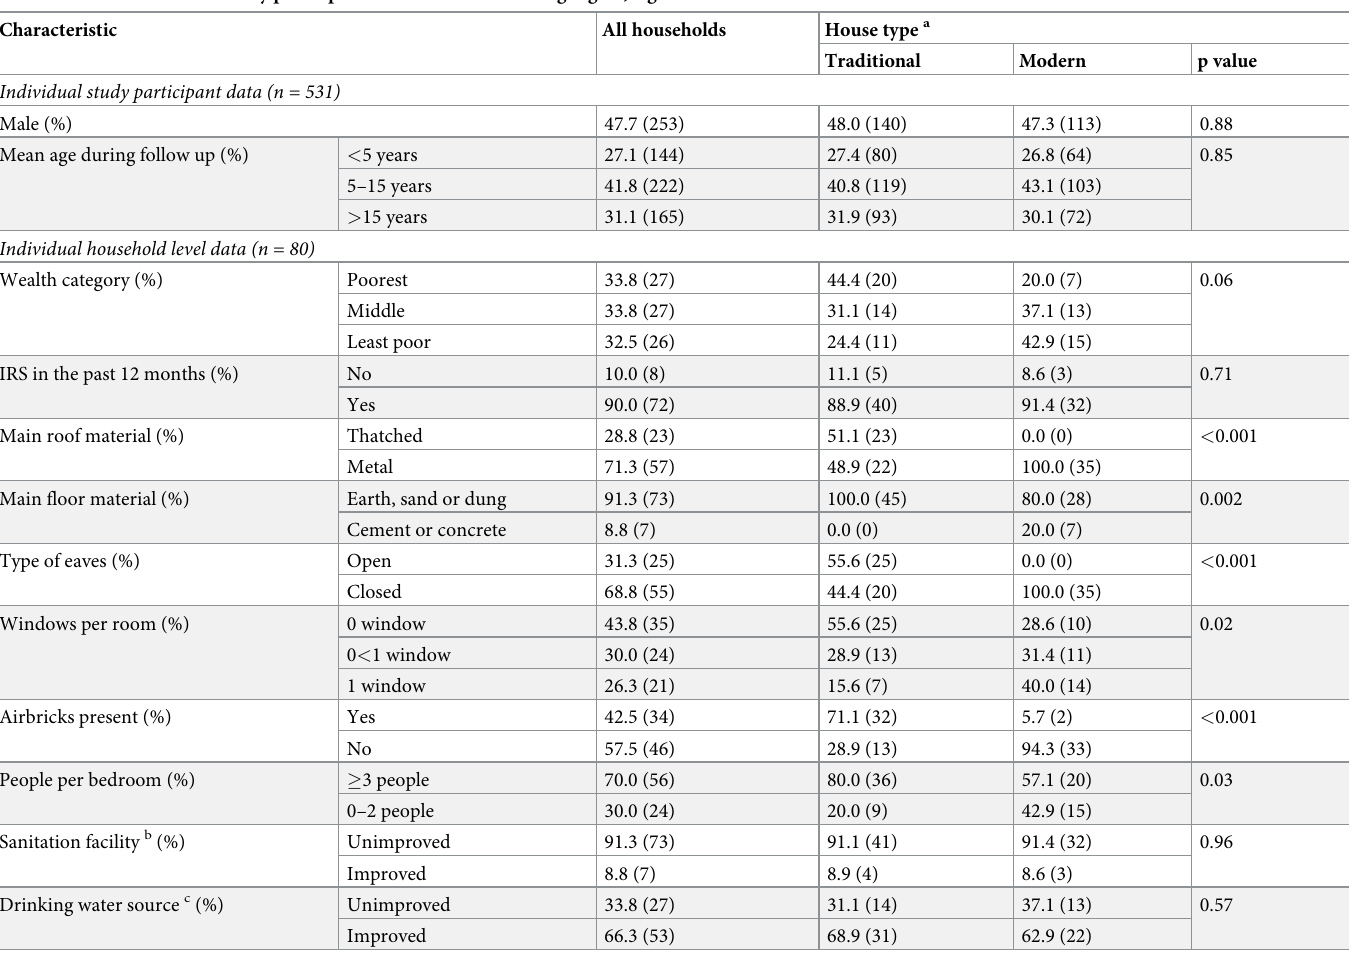
Table 1. Characteristics of study participants and households in Nagongera,